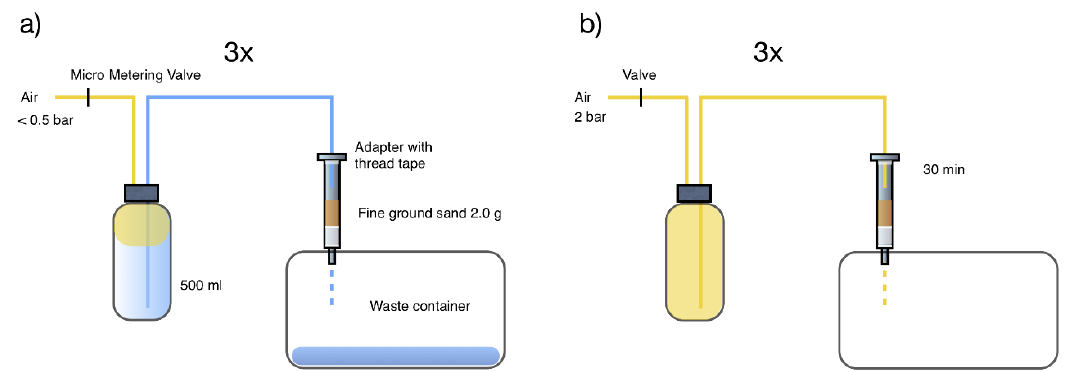
Figure 1. Schematic arrangement of ( a ) the sample loader using compressed air and sand as an in-line filter, and ( b ) the drying procedure of the solid phase extraction (SPE) columns containing analytes, matrix, SPE-polymer, and sand. Adapted from reference [9].